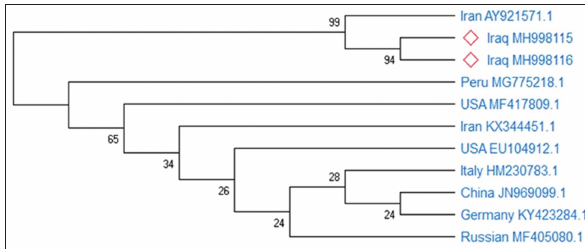
Figure-2: Phylogenic tree of two infectious laryngotracheitis Iraqi isolates using MEGA X program